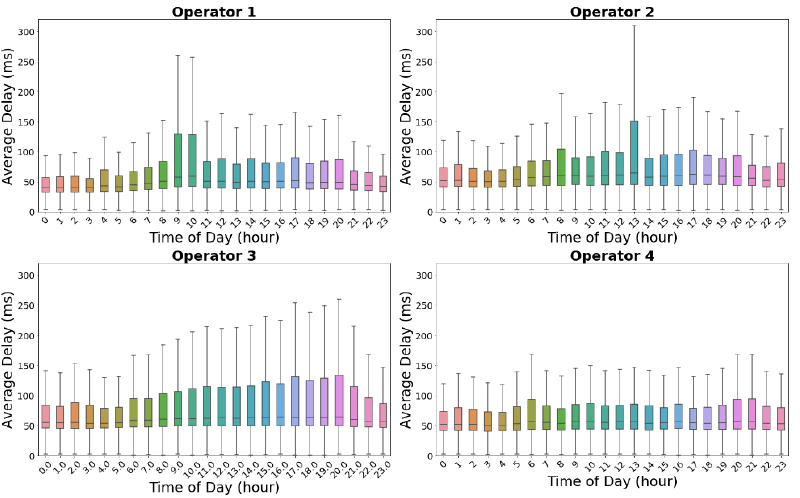
Figure 2. Average Hourly Delay Values for four UK